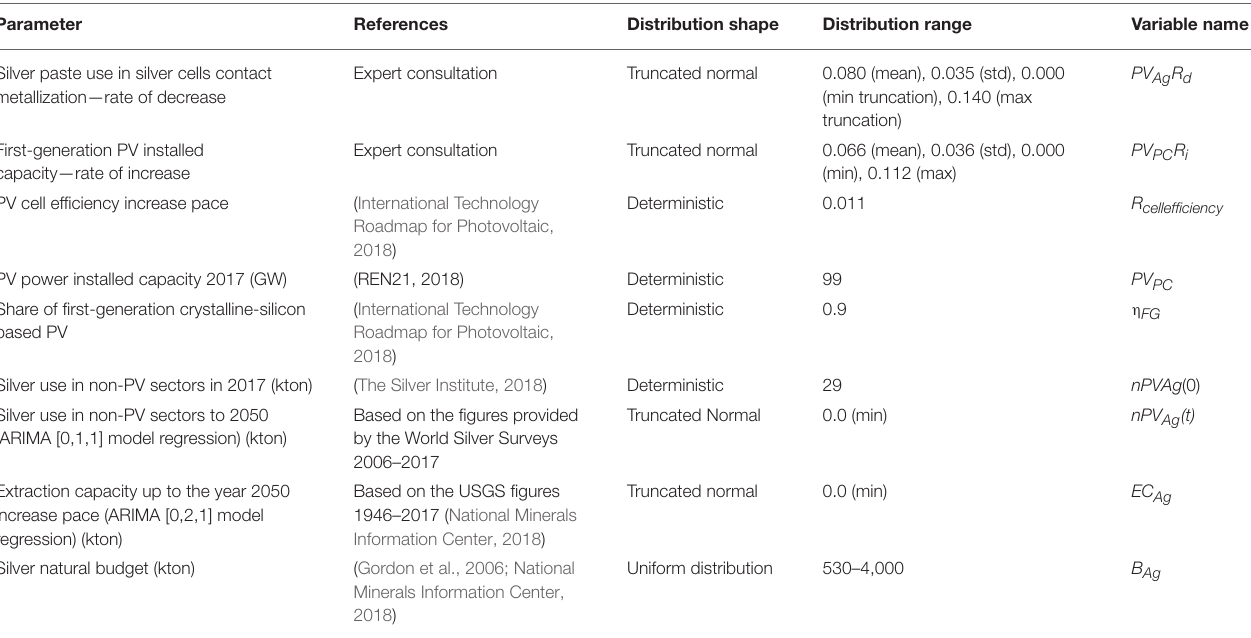
TABLE 1 | Model’s parameters sources, distributions and